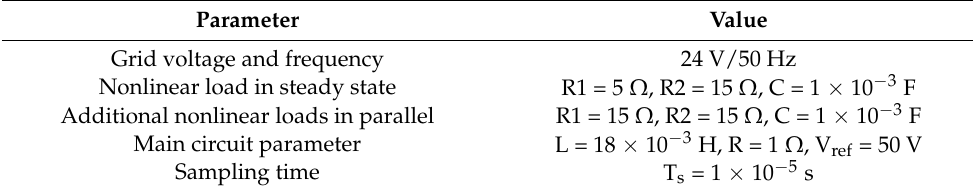
Table 1. Parameters in simulation.